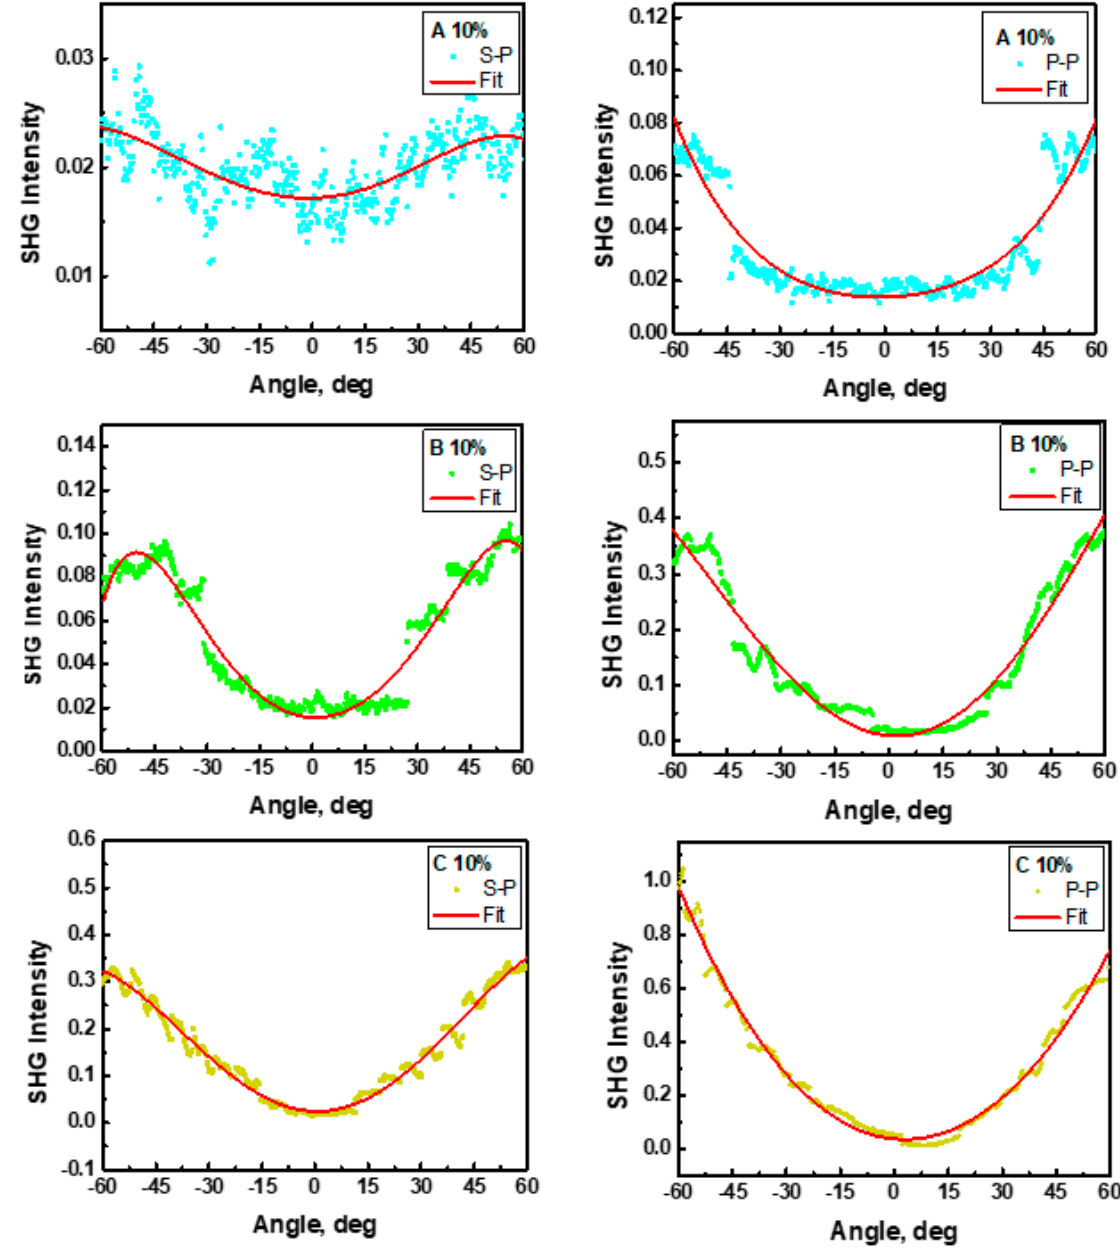
Figure 12. SHG intensity as a function of the incident angle measured for complexes A/PVK, B/PVK, and C/PVK with 10 wt% of A, B, and C chromophores in s-p ( left ) and p-p ( right ) polarization. The experimental SHG response from the A/PVK, B/PVK, and C/PVK films for the p- p input–output configuration of polarization was found to be much higher than that for the s-p polarization. This means that the studied compounds polarize the beam in the vertical direction, which may be noticed from Table 3 and Figure 13. This is also the di- rection of the electric dipole moment of the chromophores. The obtained SHG results came from the difference in values of χ (2) tensor elements responsible for the correspond- ing scheme of the experiment ( χ (2) zzz and χ (2) zxx ). The χ (2) zzz and χ (2) zxx values obtained for the investigated molecular systems remain in the ratio χ (2) zzz / χ (2) zxx = 3 [37]. A lower SHG re- sponse has been obtained for the A compound, where a substituent is a methylfuran